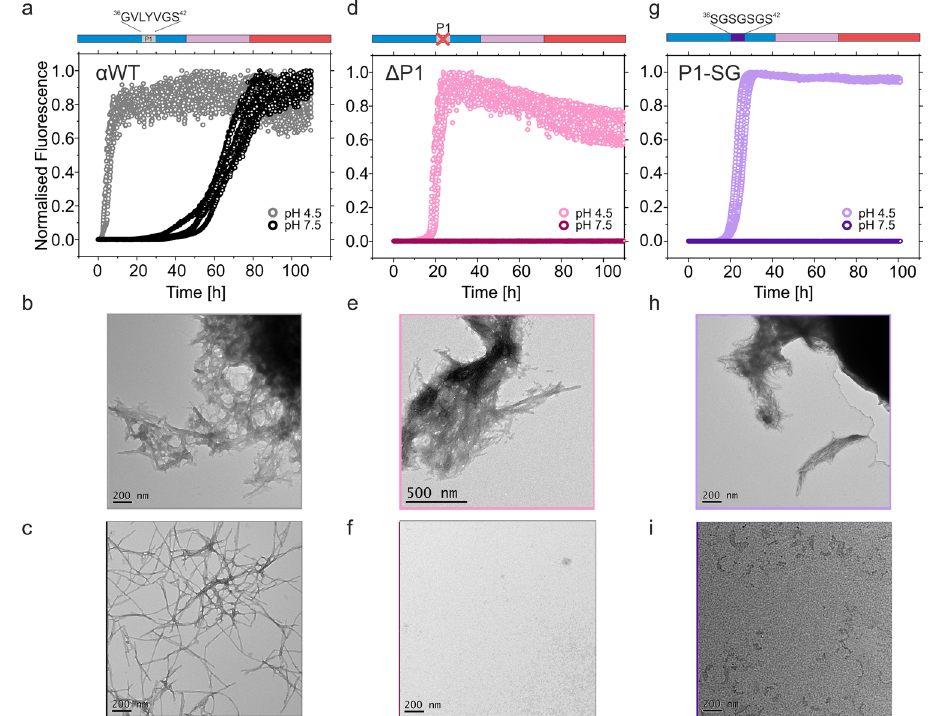
Fig. 2 | The sequence of P1 ( 36 GVLYVGS 42 ) is crucial for amyloid formation. Fibrillation of WT α Syn at pH 7.5 or 4.5 measured by a ThT fl uorescence and b , c , negative stain TEM, showing the end points of the experiment at b pH 4.5 (20mM sodium acetate) and c pH 7.5 (20mM Tris-HCl) (each in 200mM NaCl). d – f , as for a – c , but for Δ P1. g – i , as for a – c , but for P1-SG- α Syn. Each condition was measured in at least triplicate. Note that short, clumped fi brils result at pH 4.5, presumablyas fi brilformation israpid and the pHis close to the pIof the proteins.